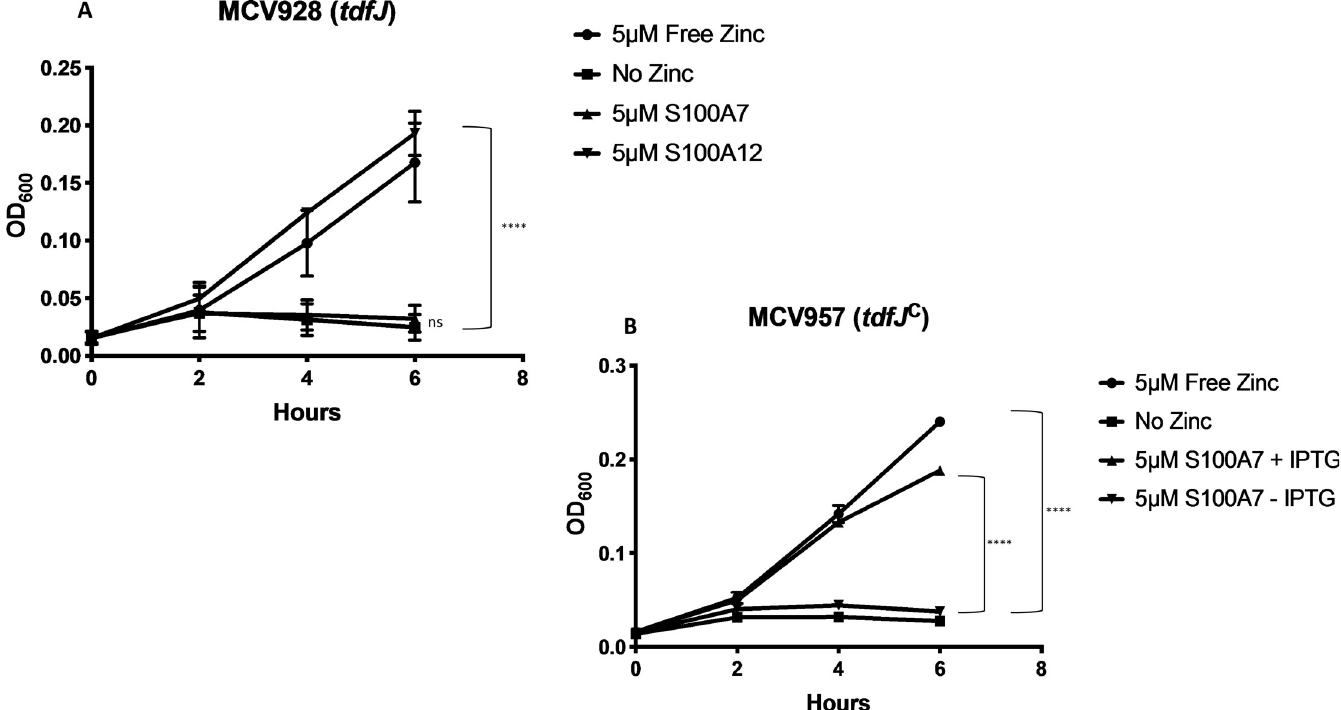
Fig 7. Neisseria gonorrhoeae requires a functional TdfJ to utilize S100A7 as a sole zinc source. (A) The N . gonorrhoeae tdfJ null mutant, MCV928, was grown in Zn- restricted CDM supplemented with growth premix containing ZnSO 4 , S100A7, S100A12, or no zinc. Growth was measured by OD 600 readings every 2 h for 6 h total. (B) The tdfJ complemented strain, MCV957, was grown as described in (A), with S100A7 containing premixes further supplemented with either 1 mM IPTG or no IPTG. Both graphs demonstrate means and SD for N = 6 and N = 3 independent experiments for (A) and (B), respectively. A 2-way repeated measures ANOVA with Tukey’s correction was performed for all means, with significance at 6 h shown. � , P � . 05; �� , P � .005; ��� , P � .0005; ���� , P �